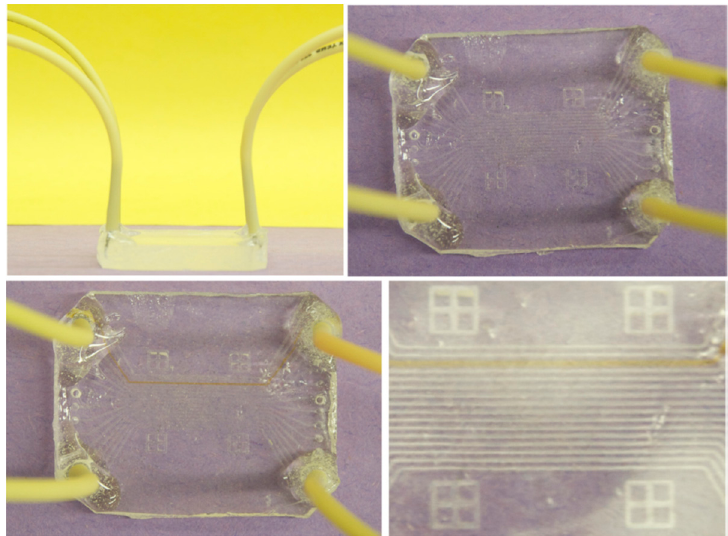
Figure 8. Images of the final annealed microfluidic device attached to inlet capillaries (top left and top right) and methyl orange solution being pumped through final microfluidic device. Reproduced with permission from [220]. Copyright 2020, Elsevier Ltd.